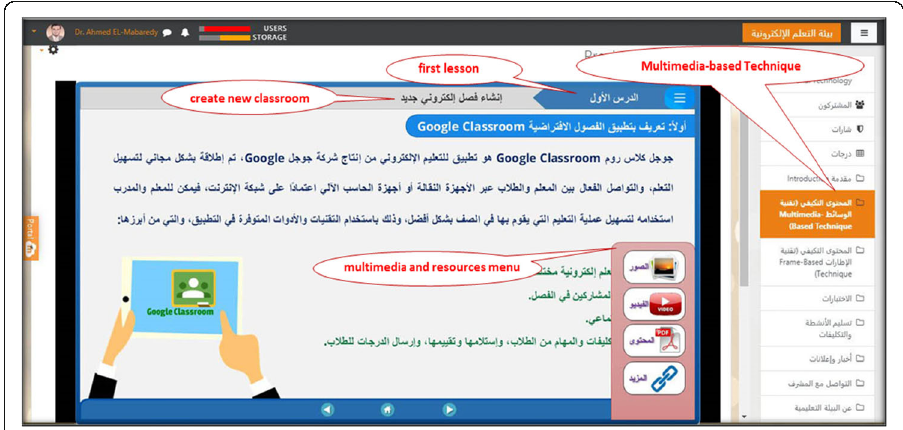
Fig. 7 Scene from multimedia-based